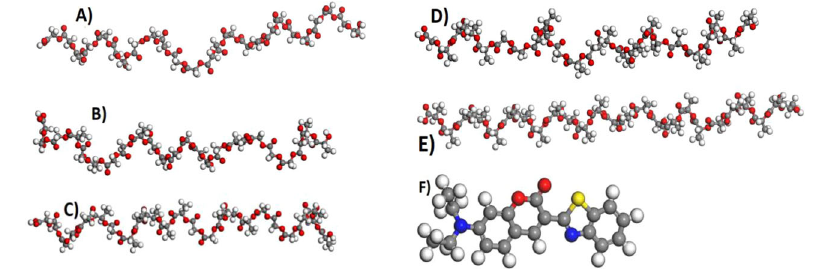
Fig. 2 A 25mer PGA chain, B 25mer PLGA27 chain, C 25mer PLGA55 chain, D 25mer PLGA72 chain, E 25mer PLA chain, and F molecular structure of coumarin-6 (in all pictures, the chains LA and